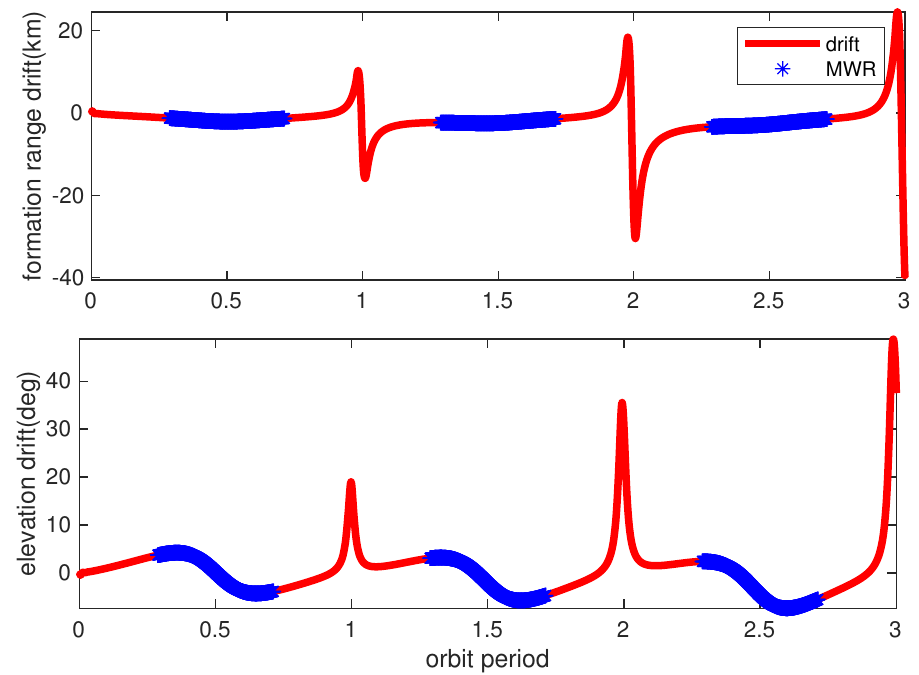
Figure 6. Formation range and elevation angle bias. The red lines represent the bias of real formation range drift from the design values ( top ) and the elevation angle drift ( bottom ). The blue lines denote the MWR equipment operation time during